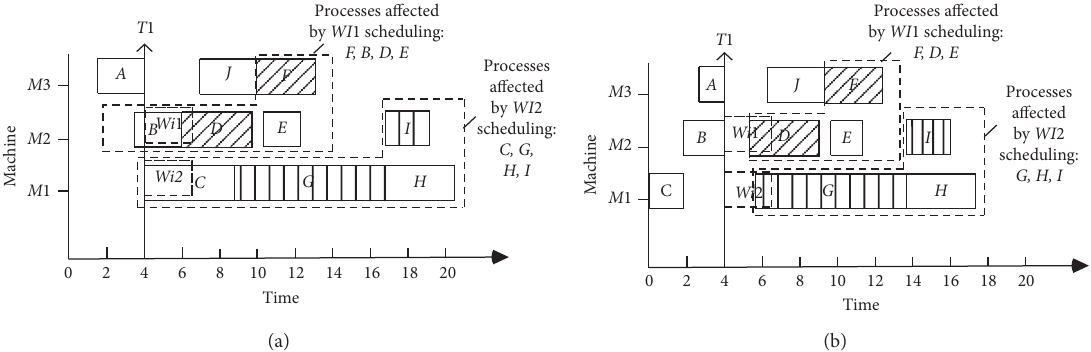
Figure 4: Scheduling analysis at the first quasischeduling time